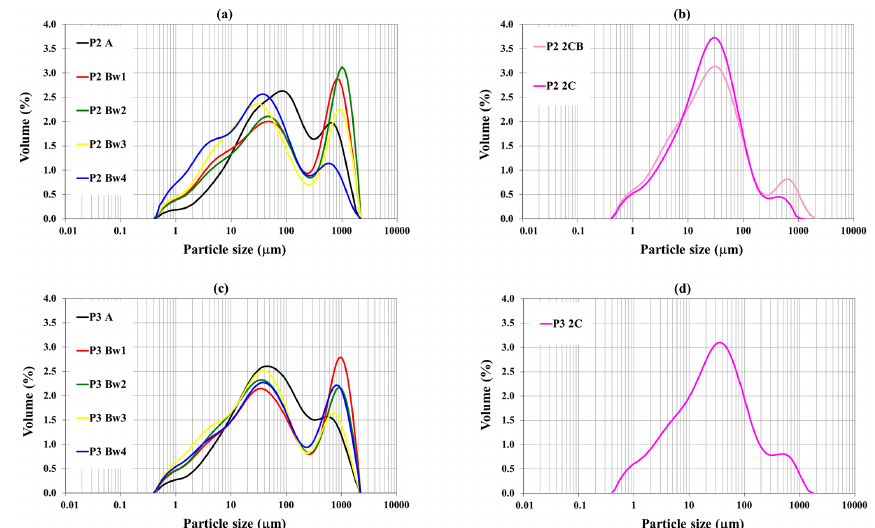
Figure 2. Particle size distribution (PSD) of (a) A and Bw horizons along soil profile P2 and (b) 2CB and 2C horizons along soil profile P2, (c) A and Bw horizons along soil profile P3, and (d) the 2C horizon along the soil profile